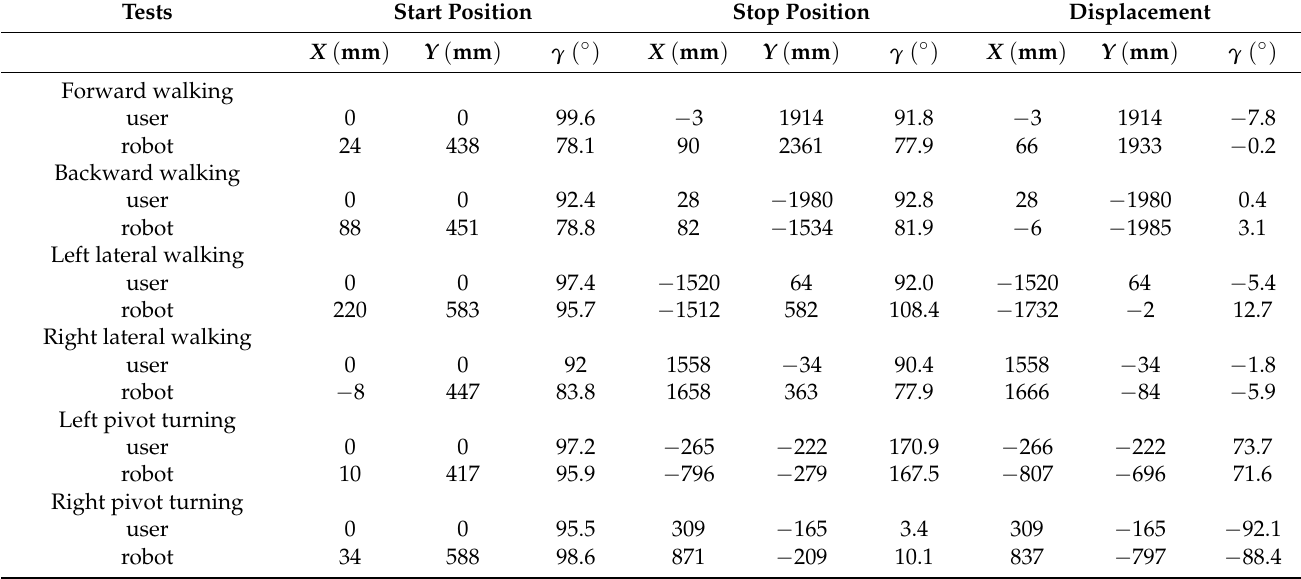
Table 1. Result of Walking Tasks in the WCS